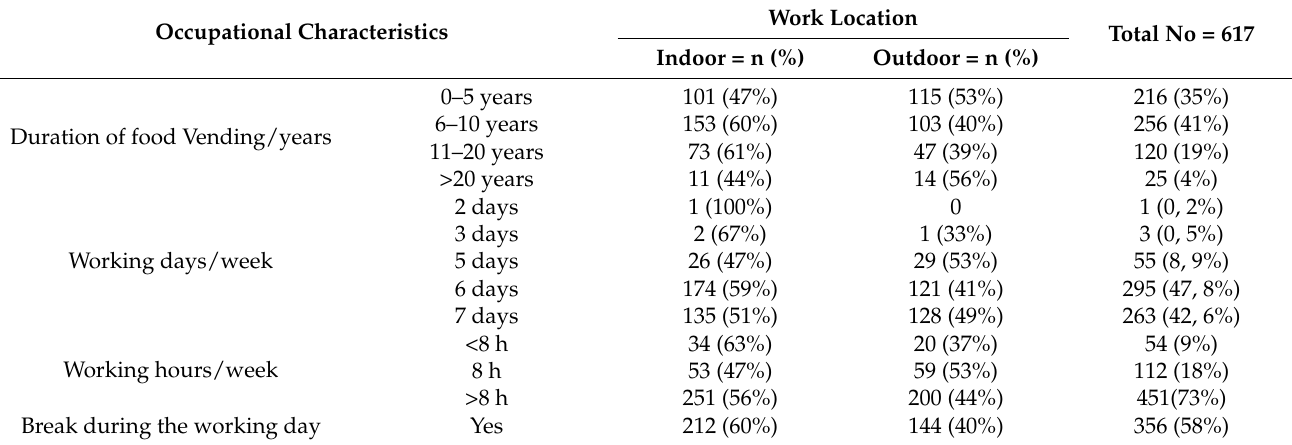
Table 3. Occupational characteristics of informal food vendors in the inner city of Johannesburg (work duration